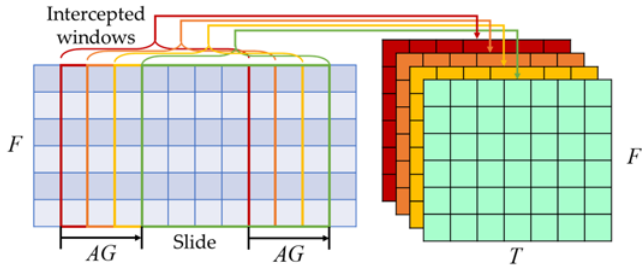
Figure 7. Diagram of the data augmentation method.